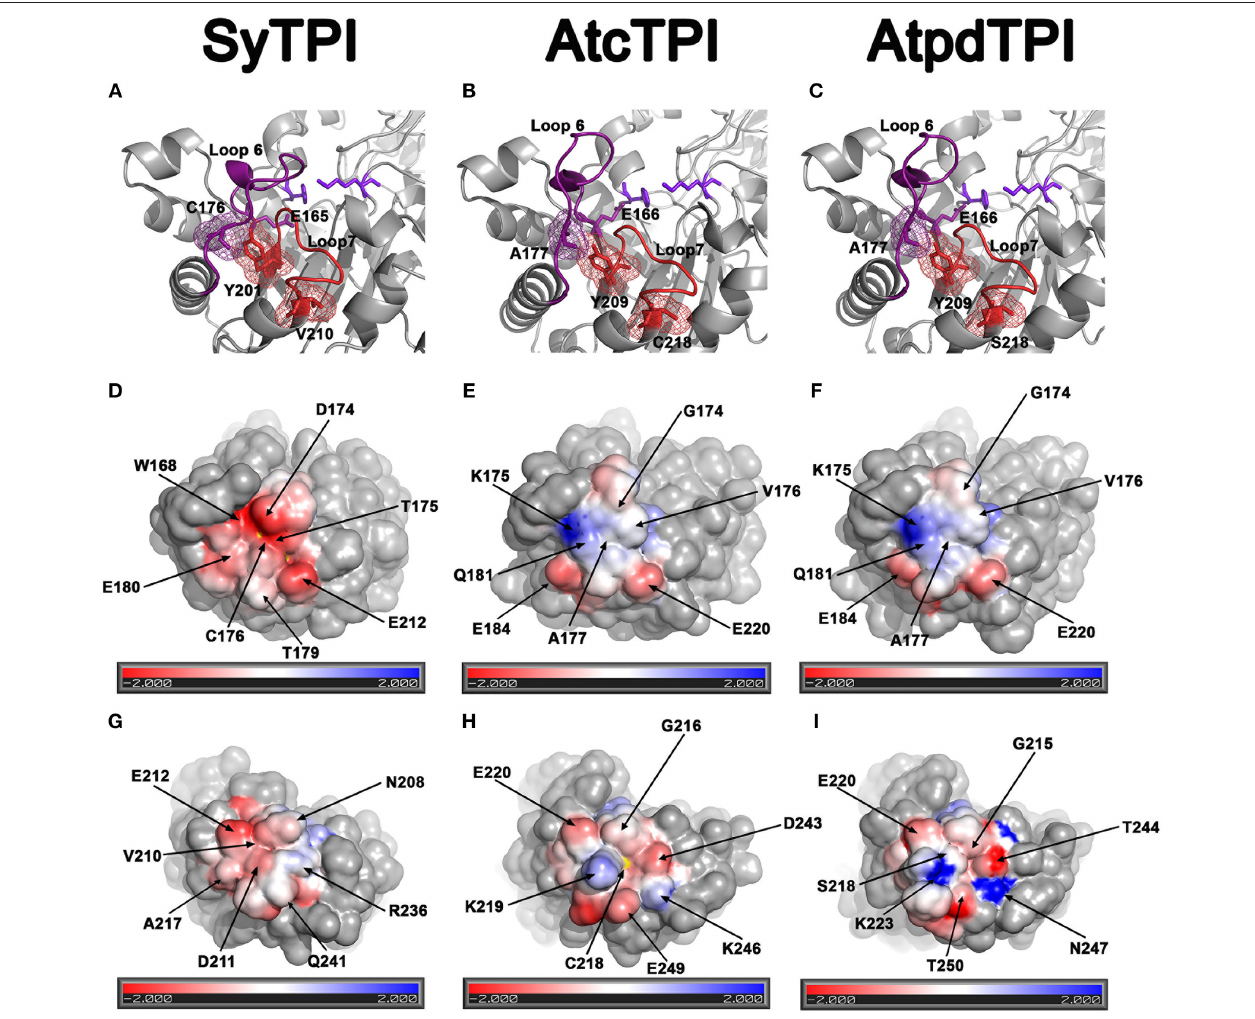
FIGURE 7 | Structural basis for SyTPI resistance to redox agents. (A–C) Close up of the α -helix 7 showing residues SyTPI-V210 (A) , AtcTPI-C218 (B), and AtpdTPI-S218 (C) colored in red in a stick representation, the three residues are located near a tyrosine (SyTPI-Y201, AtcTPI-Y209, and AtpdTPI-Y209) of the YGGS motif that makes contact with the respectively residues located immediately after (SyTPI-C176, AtcTPI-A177, and AtpdTPI-A177) to the catalytic residue (SyTPI-E165, AtcTPI-E166, and AtpdTPI-E166). Electrostatic potentials near residues SyTPI-C176, AtcTPI-A177, and AtpdTPI-A177 (D–F) , and SyTPI-A217, AtcTPI-C218, and AtpdTPI-S218 (G–I) . Negatively charged amino acids are colored in red and positively charged amino acid in blue. The thiol group of SyTPI-C176 and AtcTPI-C218 are colored in